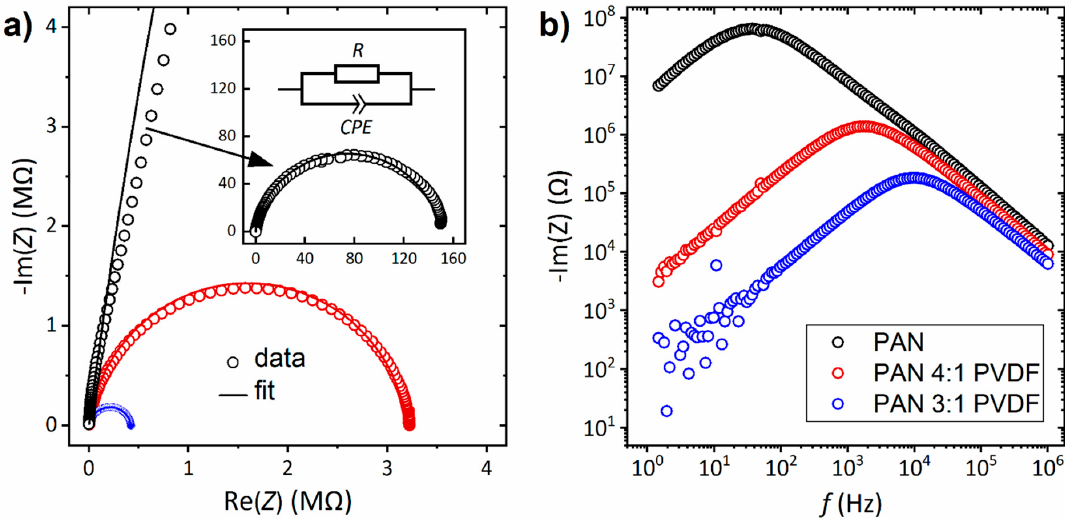
Figure 9. Impedance spectra of all carbonized nanofibers at 25 °C: ( a ) imaginary part vs. real part (Nyquist plot); and ( b ) imaginary plot vs. frequency (Bode plot).